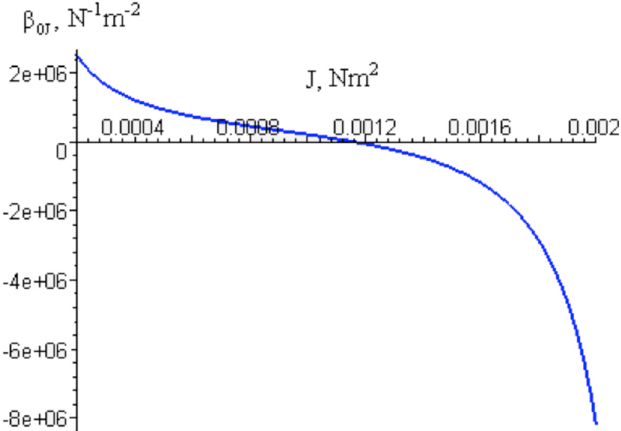
Fig. 5. The coef fi cient affecting the impact value J on the output